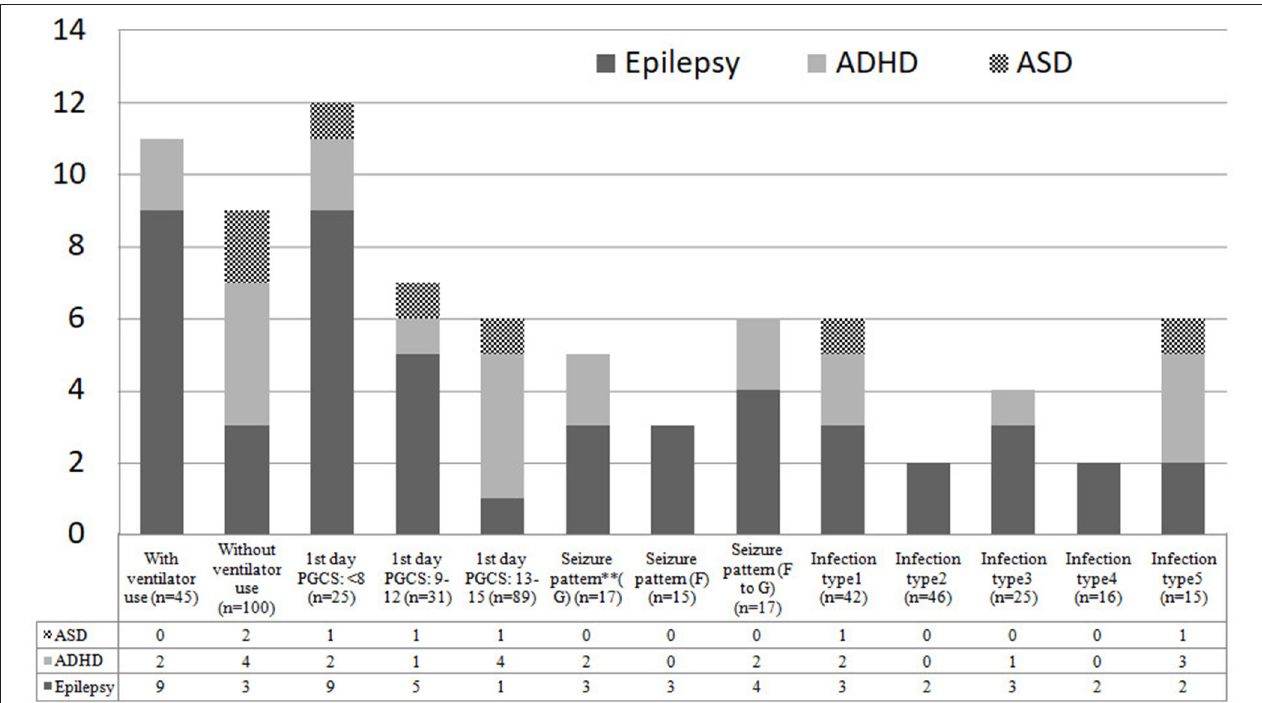
FIGURE 4 | Possible risk factors during admission for subsequent NDDs among 145 study children. PGCS, Pediatric Glasgow Coma Scale; F, focal; G, generalized; F to G, focal seizures evolving to secondarily generalized seizures; Infection type 1: meningitis; Infection type 2: Encephalitis; Infection type 3: meningoencephalitis; Infection type 4: Encephalomyelitis; Infection type 5: other brain infections types. ** Seizure patterns were classified into focal, generalized, focal to generalized, according to their clinical features of seizures and electroencephalographic data.